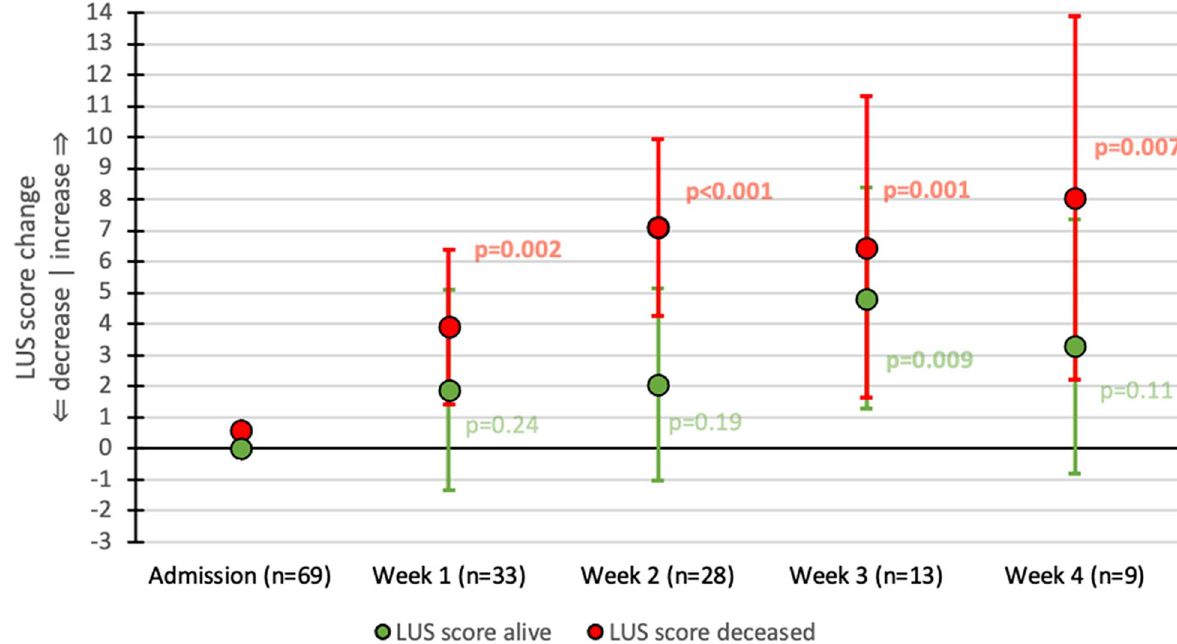
Fig. 4 LUSS changes over time compared to admission. LUSS: lung ultrasound score. Each point represents the mean score change compared to respective admission with its 95% confidence interval. Green points: patients who survived. Red points: patients who died. P values at follow-up points should be interpreted as the significance of the change of that particular point compared to baseline. Significant p values are in bold. At admission, there was no difference between the LUSS of patients who survived until discharge or died during admission ( p